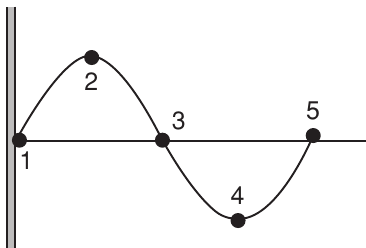
Figure 8 Figure shows the initial points of each segment.